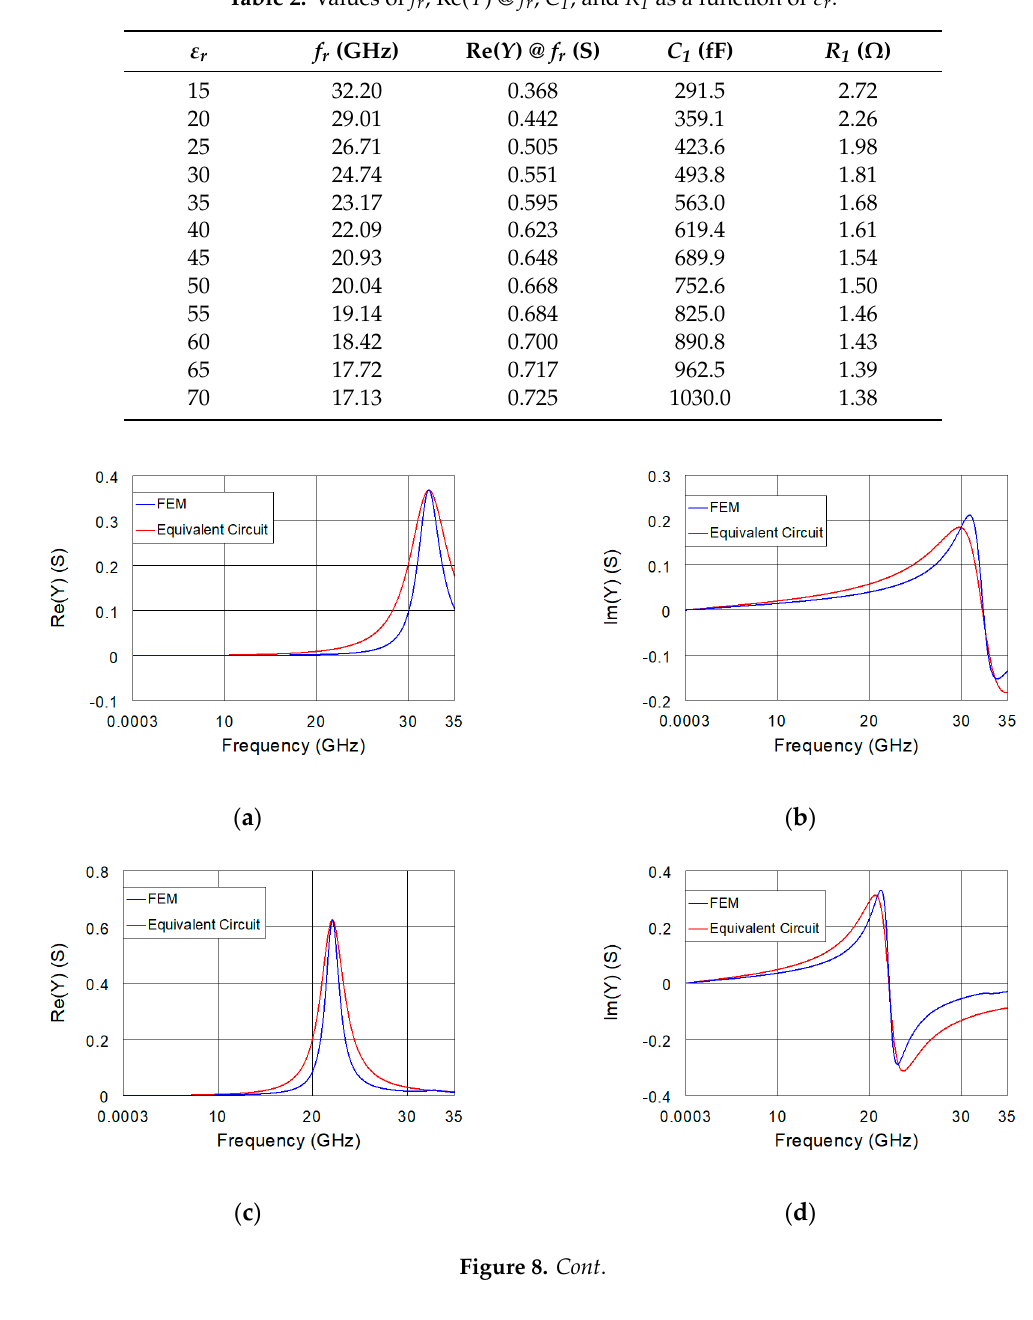
Figure 7. Behavior of the ( a ) absolute and ( b ) relative sensitivity of C 1 to variations in ε r for the lossless MUTs placed on top of the sensing area of the IDC sensor. The average values of S C1 and RS C1 are 13.35 fF/ Δ 1 and 4.58%, respectively. Table 2. Values of f r , Re( Y ) @ f r , C 1 , and R 1 as a function of ε